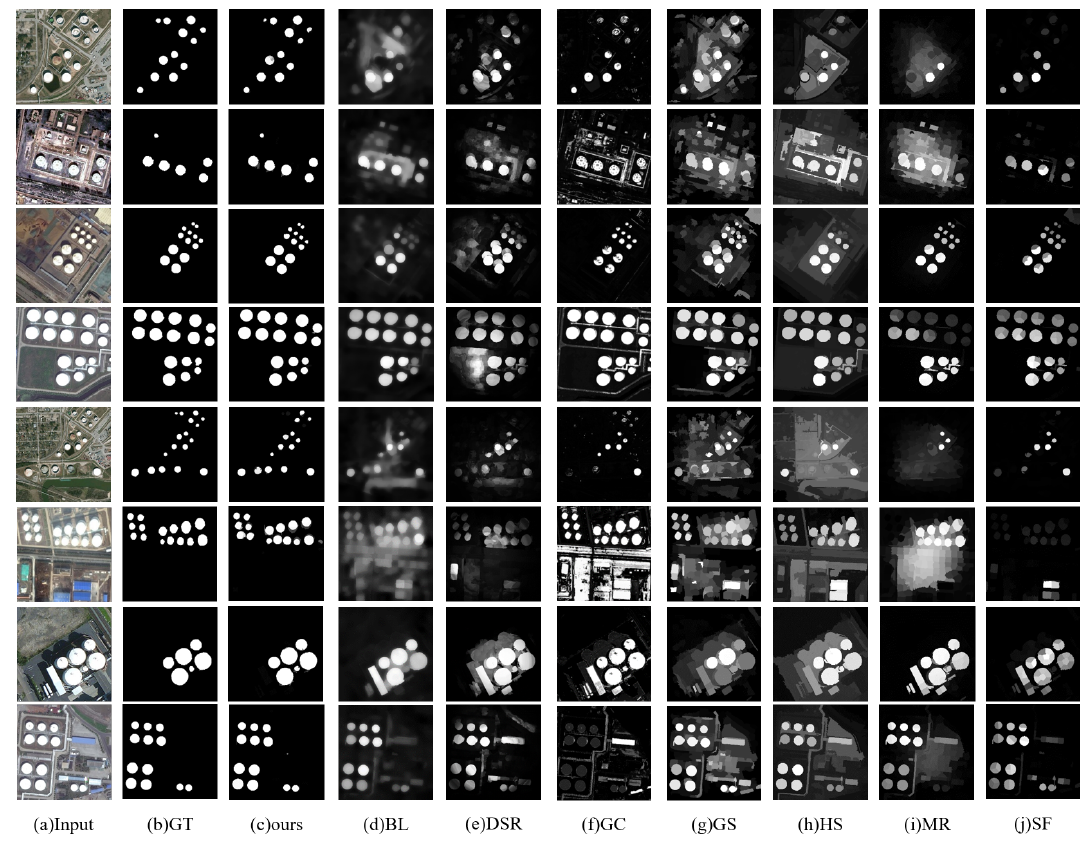
Figure 8. Comparison of results with other saliency